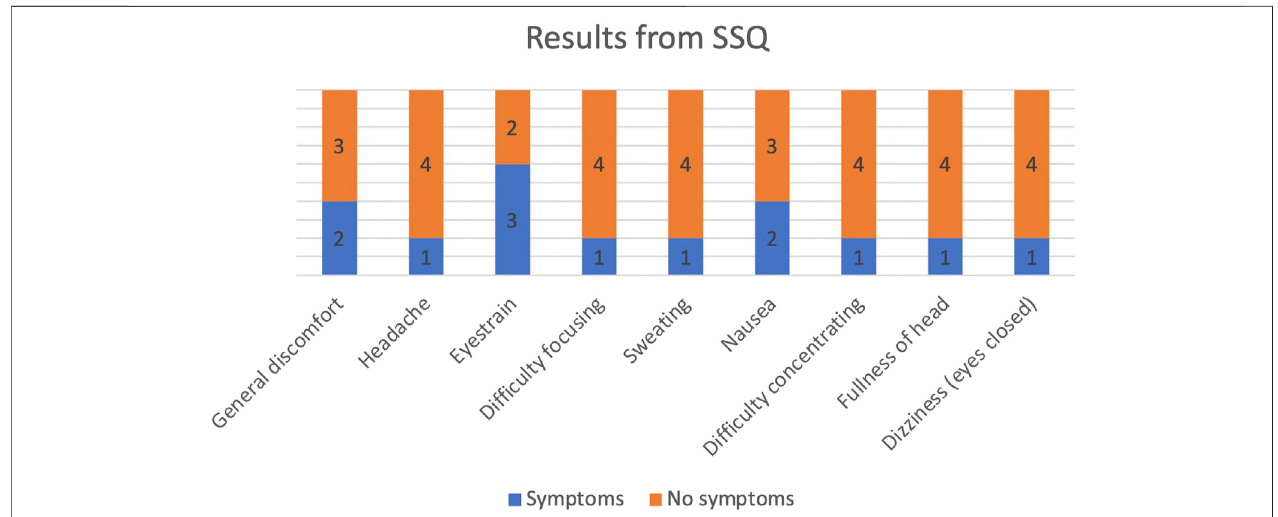
FIGURE6| RepresentationofSSQresultsfrom Table6 :Thisshowshowmanyparticipantsexperiencedmildsymptoms(Scoreof1or2inSSQ)ofcybersickness.